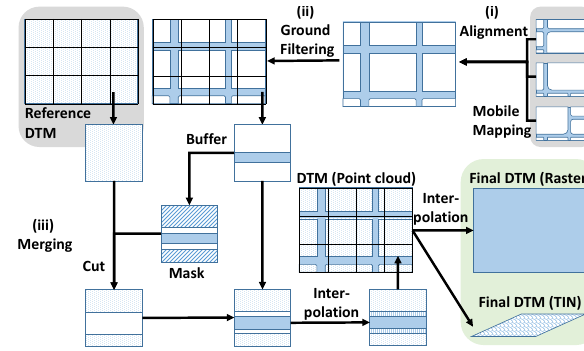
Figure 4. Work flow of our pipeline